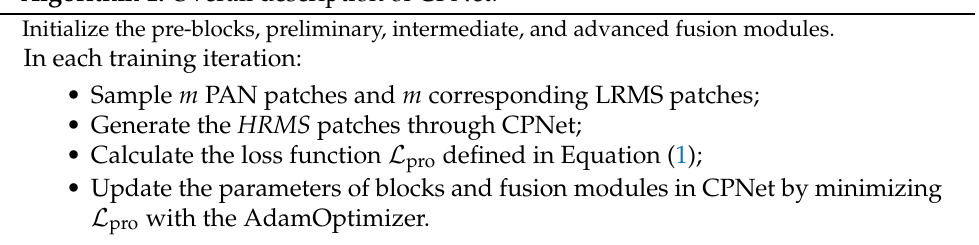
Algorithm 1: Overall description of